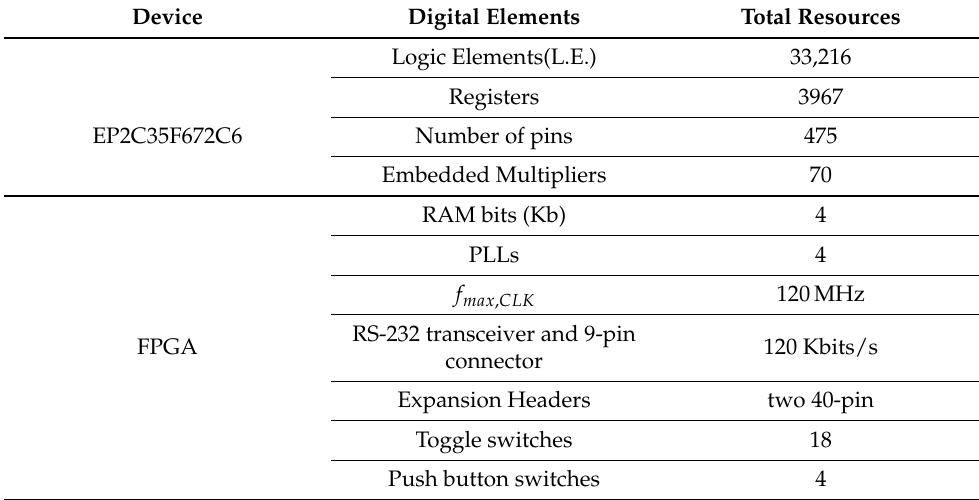
Table 3. Specifications of the FPGA ALTERA DE2.